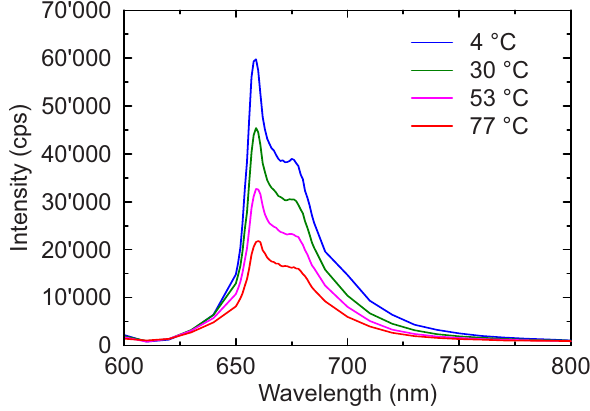
Figure 3. Emission spectrum of the sample with a Mn 4 + doping concentration of 0.40% at different temperatures.